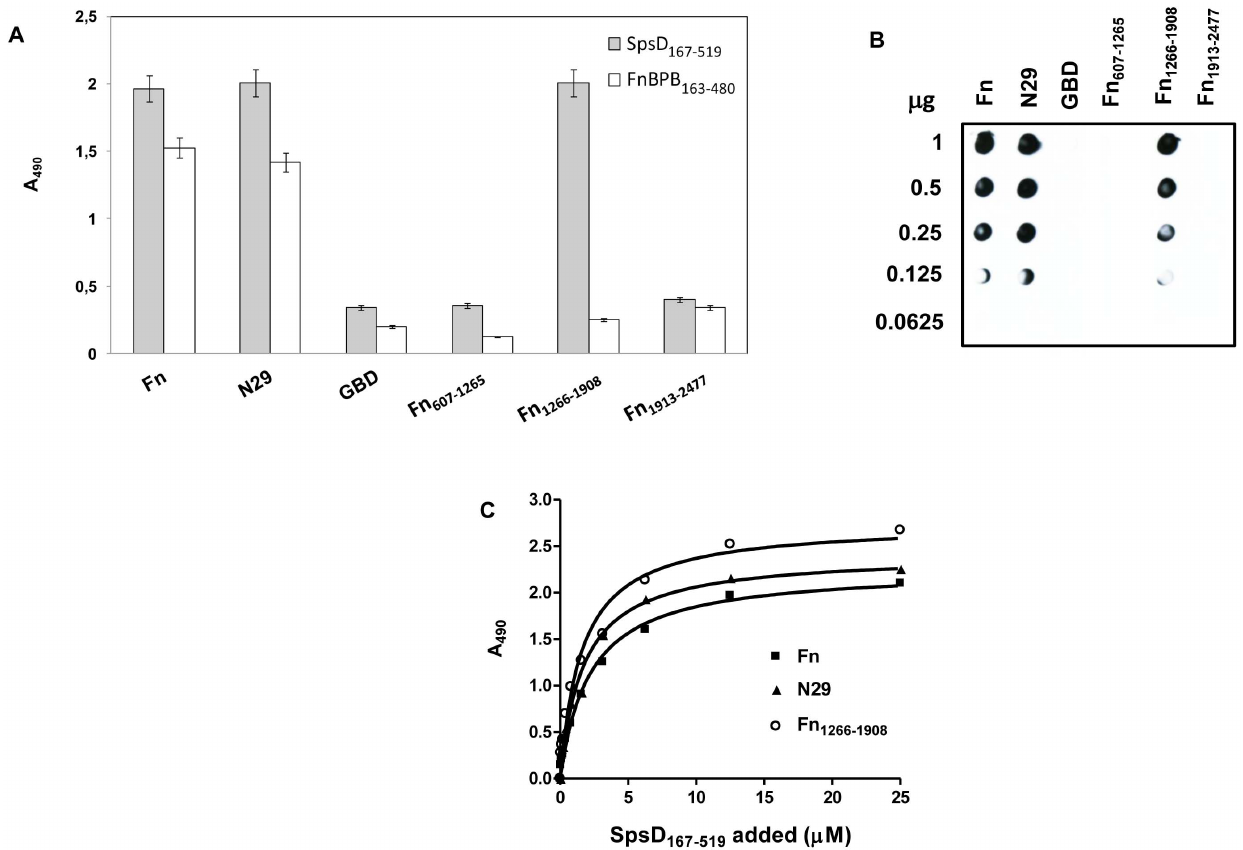
Figure 6. Localization of SpsD binding sites in Fn. (A), native Fn, the N29, the GBD, the recombinant fragments Fn 607–1263 , Fn 1266–1908 and the C-terminal region Fn 1913–2477 of Fn were immobilized onto a microtiter plate and then incubated with of SpsD 167–519 . Bound protein was detected by addition to the wells of anti-SpsD 37–519 mouse antibody, followed by HRP-conjugated rabbit anti-mouse antibody. Binding of FnBPB 163–480 to Fn